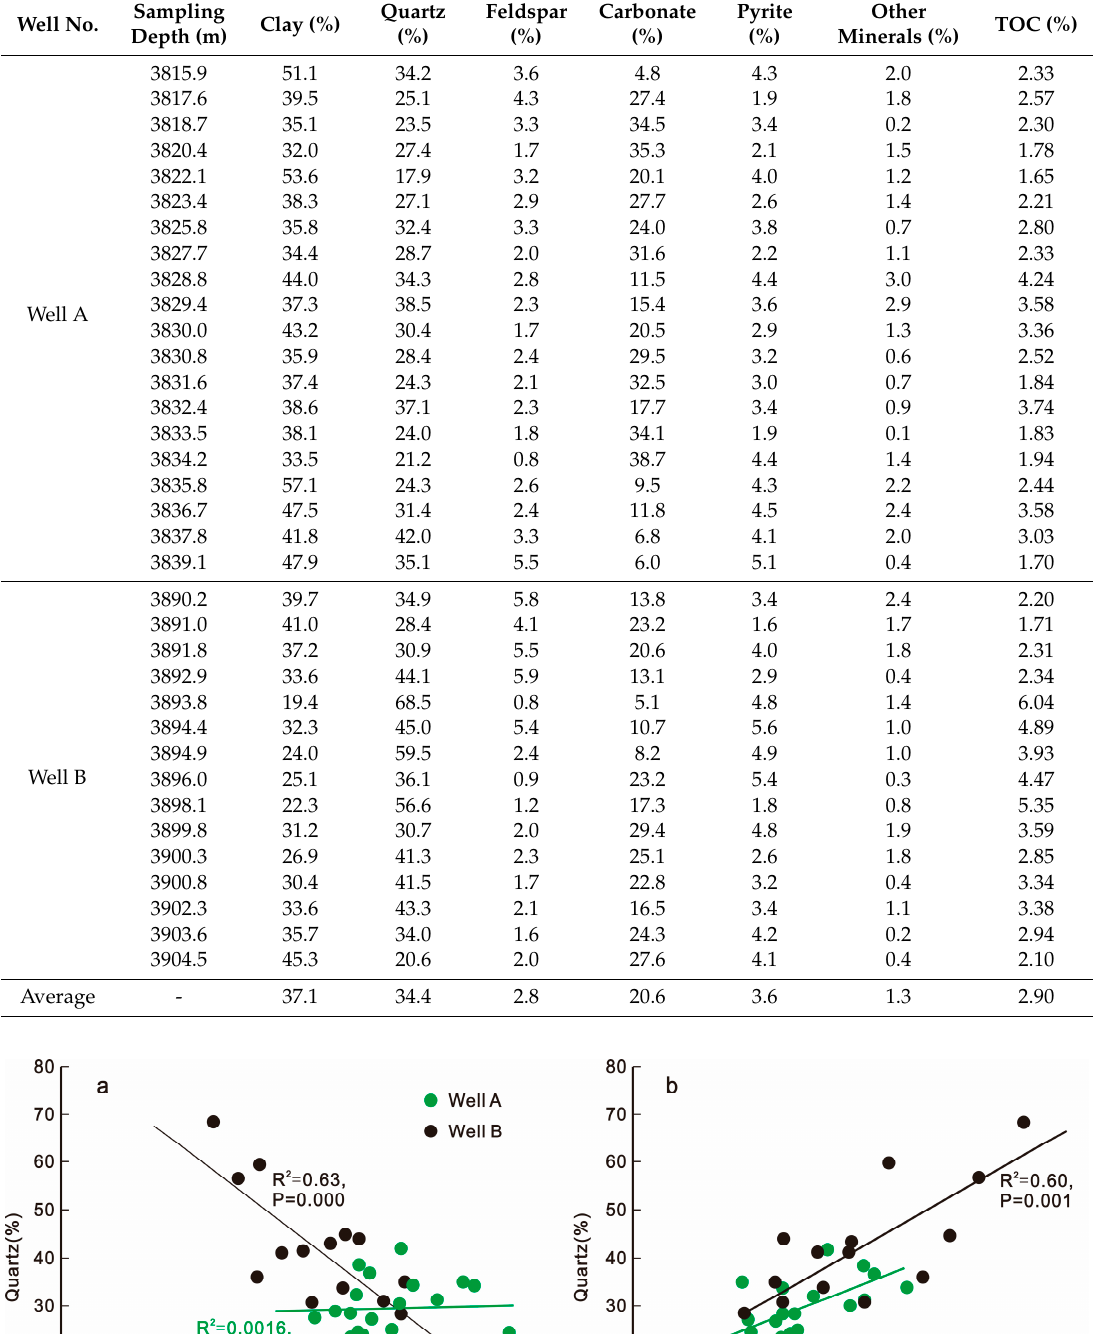
Table 2. Mineral components and TOC content of the organic-rich shales in the Wufeng and Longmaxi Formations of Upper Yangtze Wells A and B. Well No.